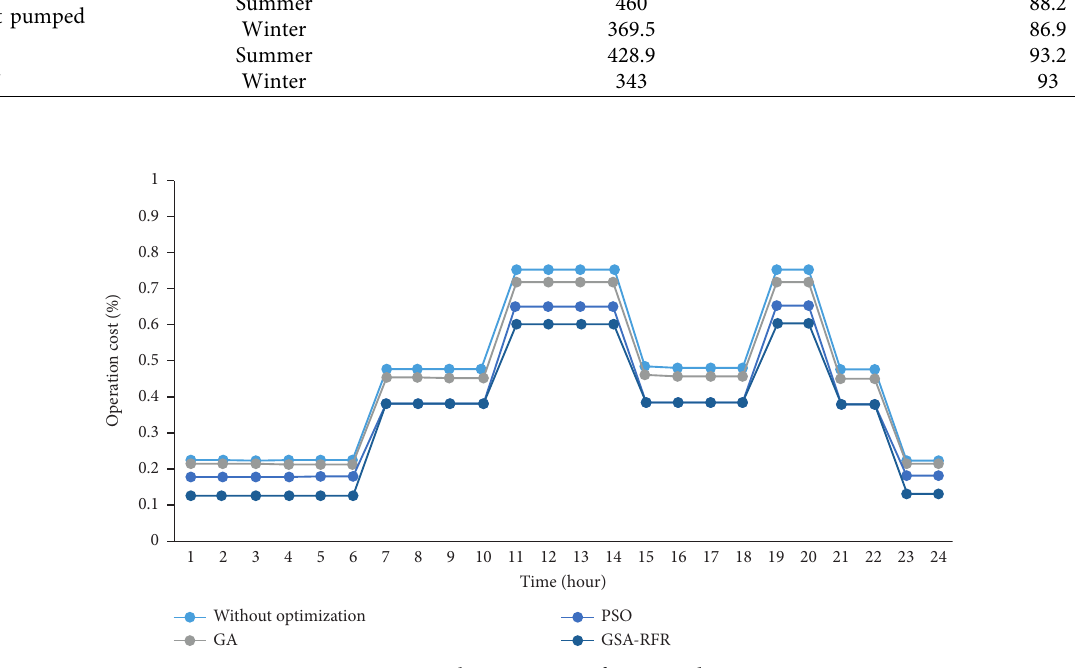
Figure 8: Electricity cost of